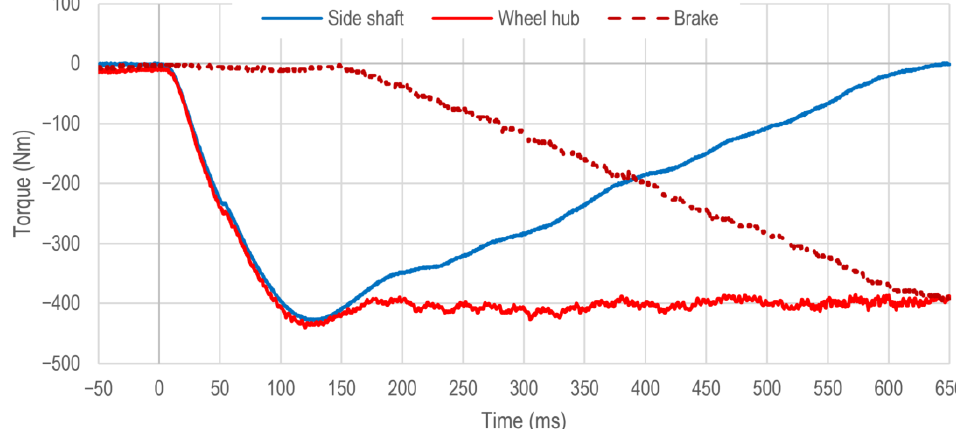
Figure 16. Braking operation with a variable split between the drive machine and the conventional vehicle braking system from 25 km/h with activated prefilter and anti-jerk control.